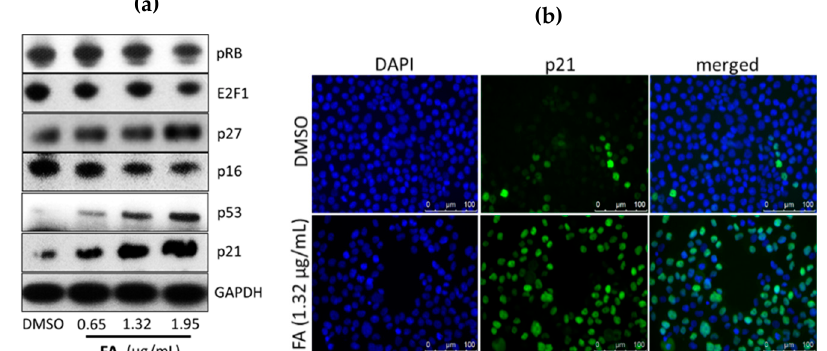
Figure 7. The up-regulation of p21 and related regulators post-FA treatment. ( a ) For Western blotting analysis, cells were treated with DMSO (0.5%) or FA at indicated concentrations for 48 h prior to protein extraction. GAPDH and histone H3 were served as loading references of the cytoplasmic and nuclear fractions, respectively. Shown here are representative immunoblots from at least three independent experiments. ( b ) For immunofluorescent staining, cells were treated with DMSO (0.5%) or FA (1.32 μ g/mL) for 48 h prior to fixing. The immunoreactivities of p21 were stained green with FITC, whereas nuclei were stained blue with 4 ′ ,6-diamidino-2-phenylindole (DAPI). Shown here are representative immunofluorescent images from three independent experiments (scale bar = 100 μ m).